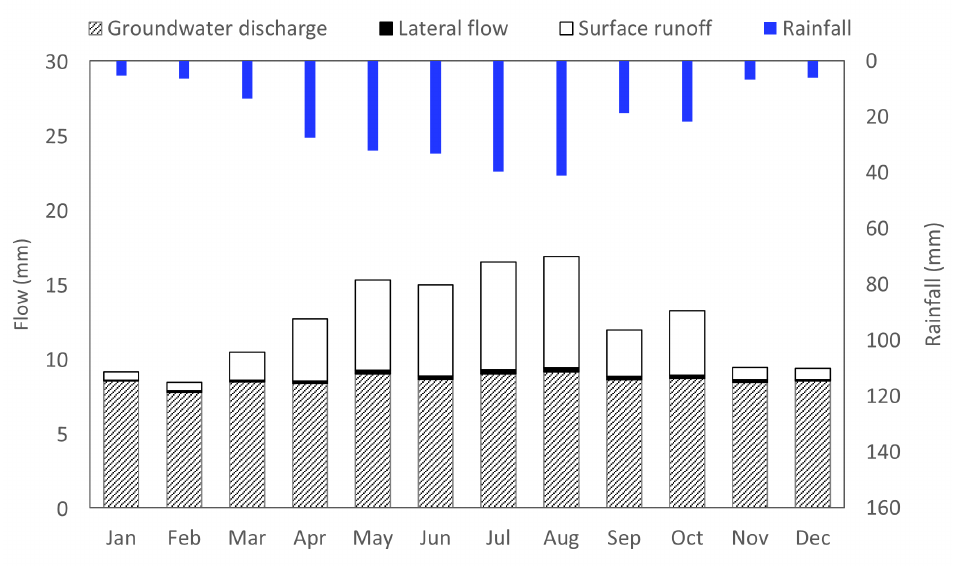
Figure 5. Monthly average water budget and rainfall in the study